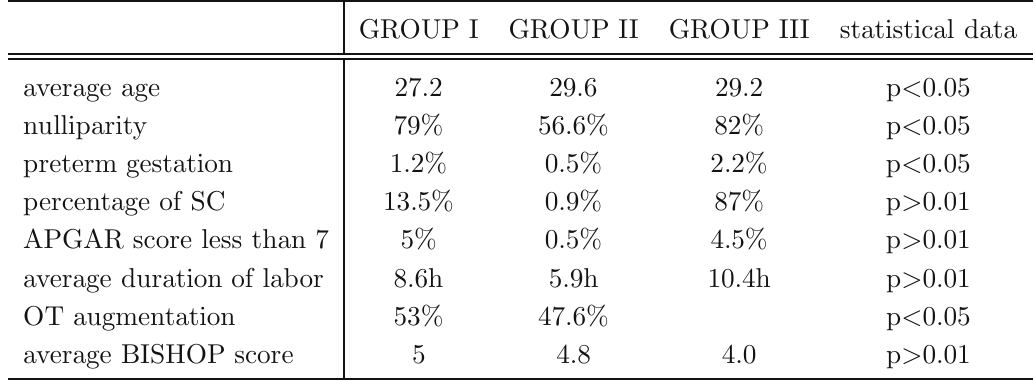
Table 1 The summary results of the